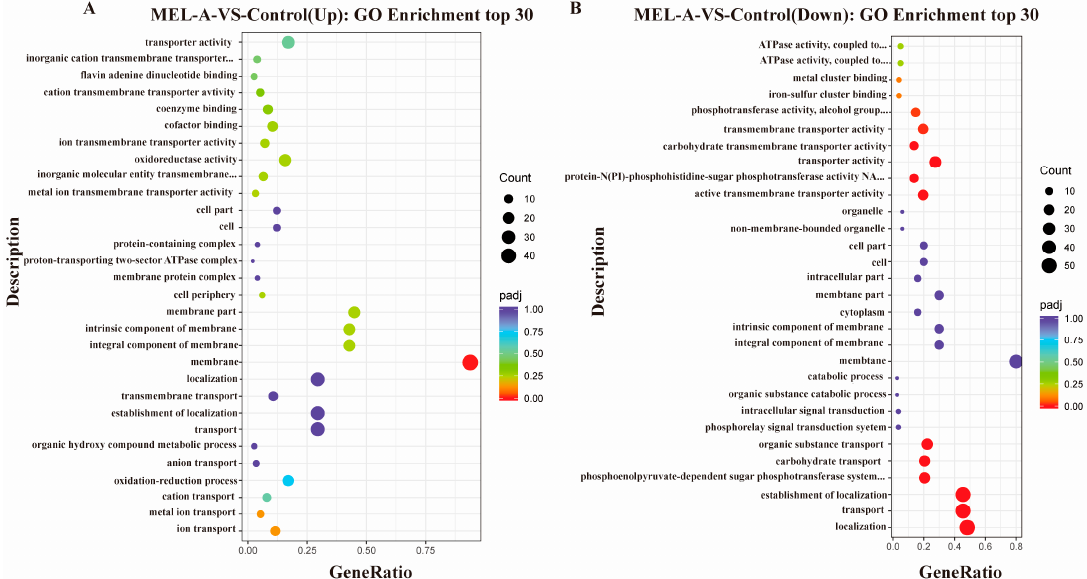
Figure 6. Scatter plot of gene ontology (GO) enrichment analysis: ( A ) scatter plot of the upregulated genes; and ( B ) scatter plot of the downregulated genes. The cut o ff value was screened based on p < 0.05 and | log2(FC) | > 1. The abscissa is the ratio of the number of di ff erential genes annotated to GO Term to the total number of di ff erential genes, and the ordinate is the GO